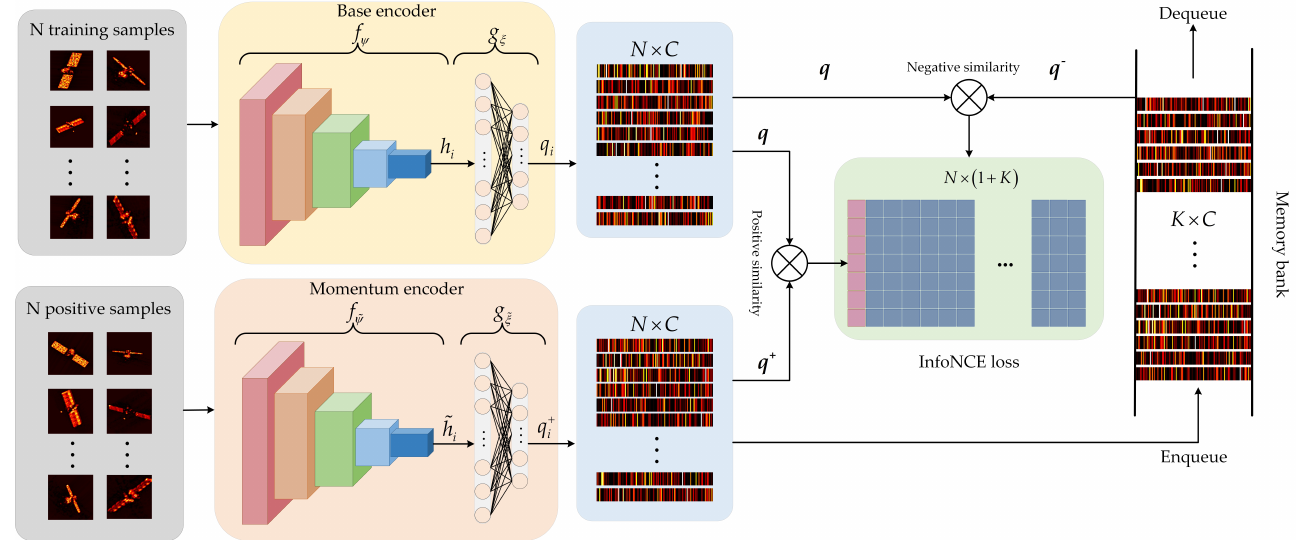
Figure 6. The optimization flow of the encoder in CLISAR-Net. The update of base encoder is realized by backpropagation of the InfoNCE loss, and the momentum encoder is updated in a momentum